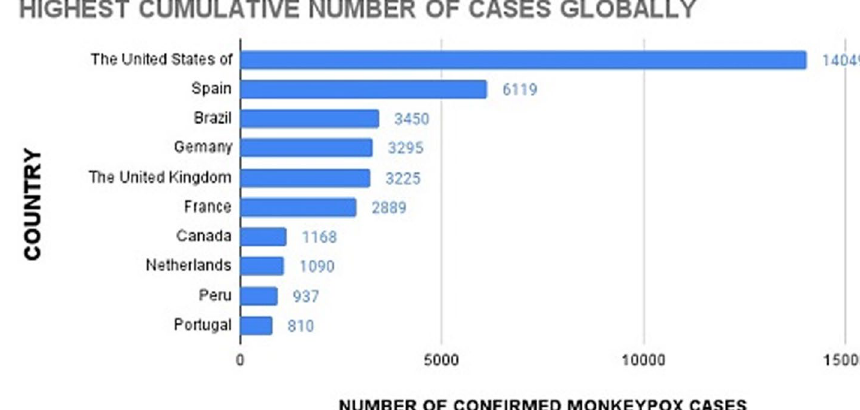
Fig. 1 Ten countries with highest cumulative number of Monkeypox cases globally (World Health